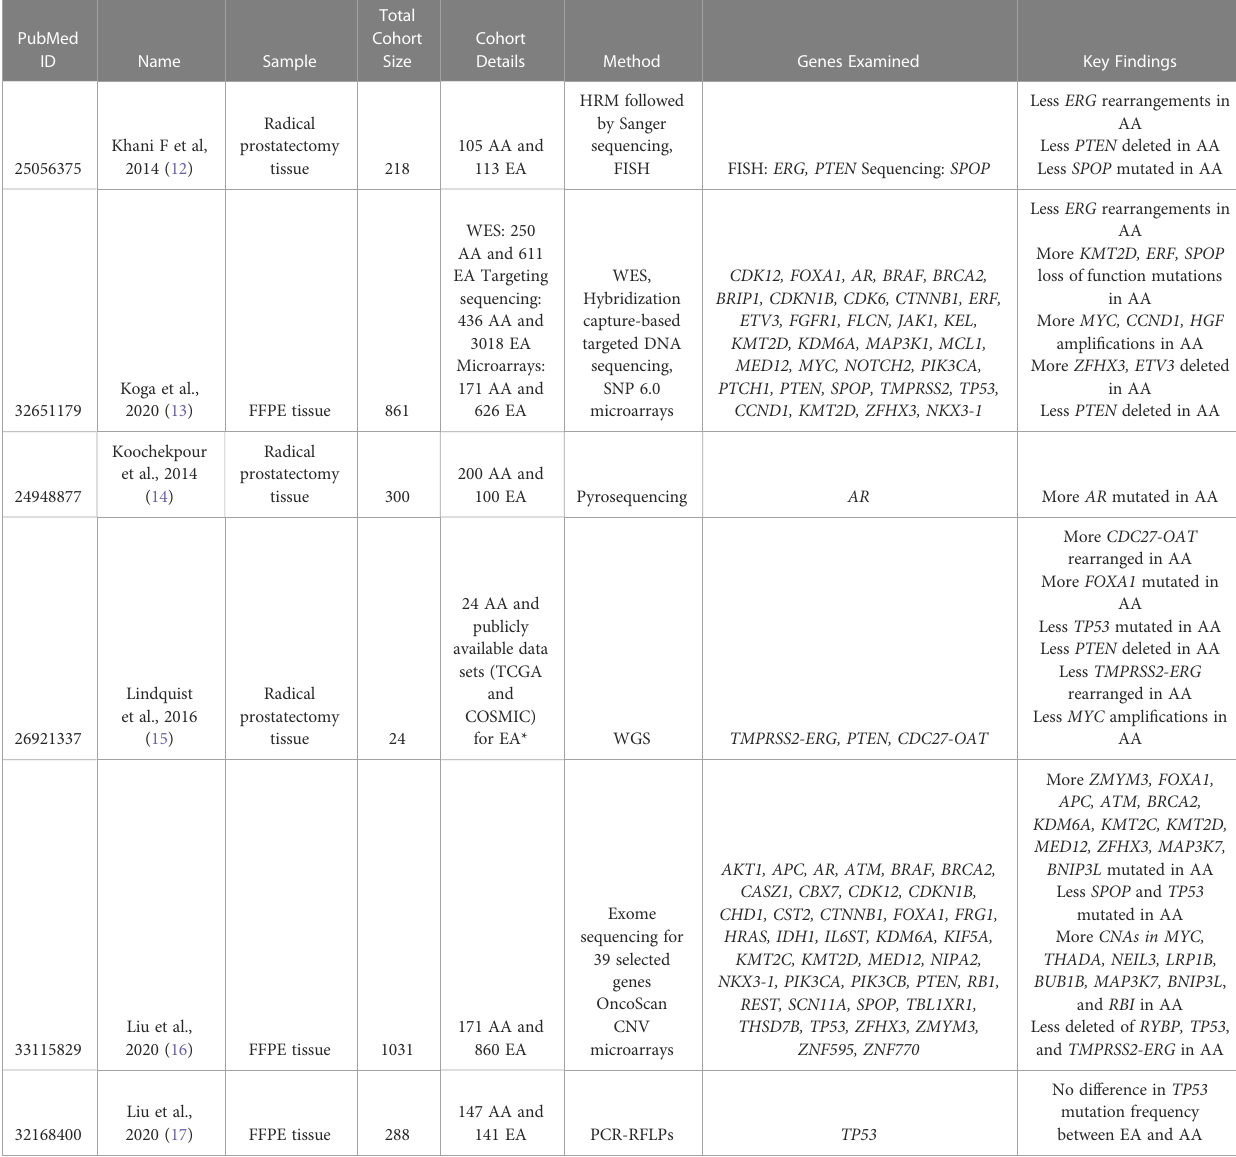
*Generated as part of a previous